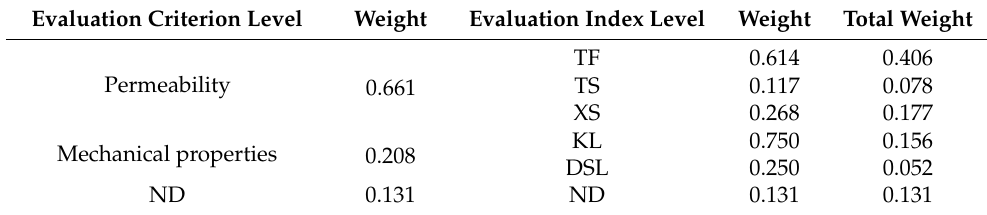
Table 6. Weight distribution of different indices.